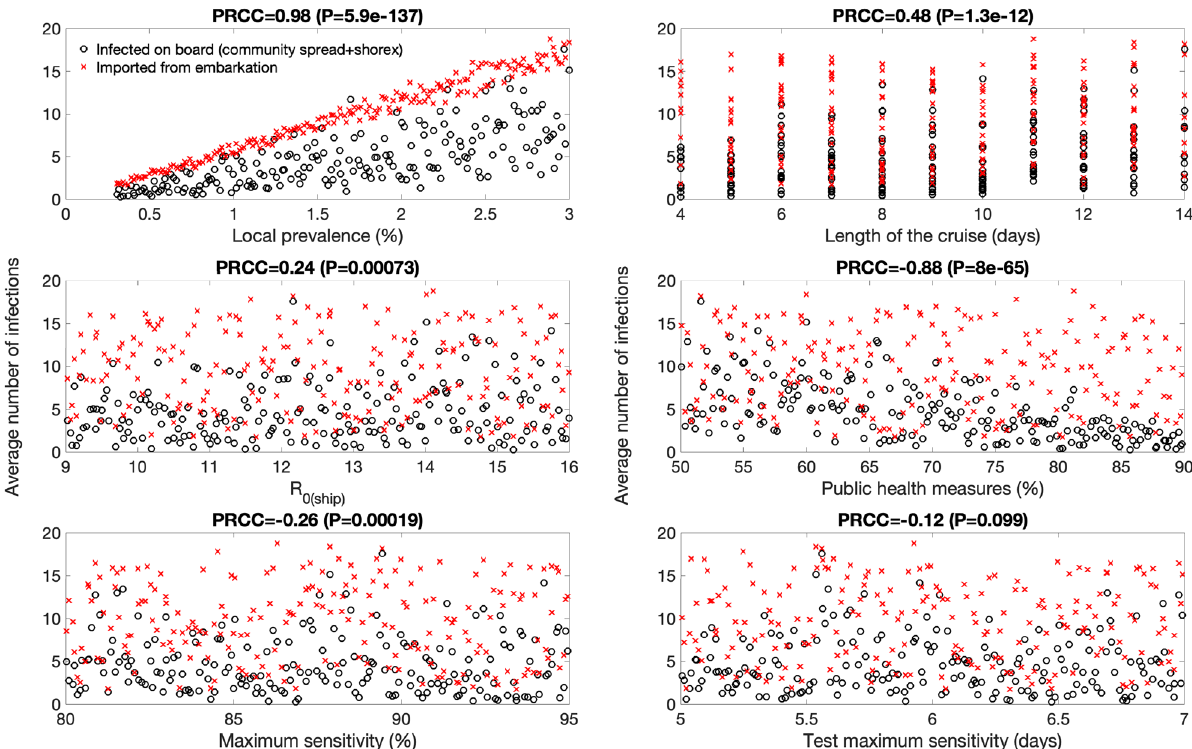
Figure 9. These scatter plots display the relationship between the model parameters and the average number of infections in the context of embarkation and daily testing together with social distancing protocols. Partial rank correlation coefficients (PRCC) and their statistical significance (P value) after considering the uncertainty ranges for each parameter (Table 1) are also shown. Local prevalence and the extent of public health measures are positively correlated with the expected number of cases at the end of the simulations. The basic reproduction number aboard the ship does not play a significant role while the length of the cruise is only weakly correlated and does not substantially affect the